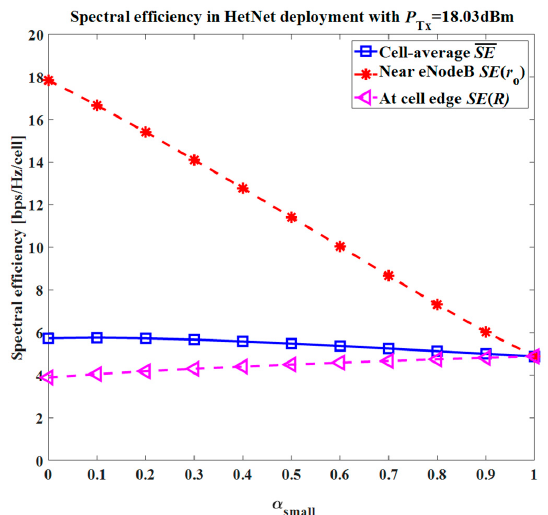
Figure 16. Spectral efficiency for the small cell as a function of distance and α small in the HetNet deployment with small cells near the macro cell eNodeB.